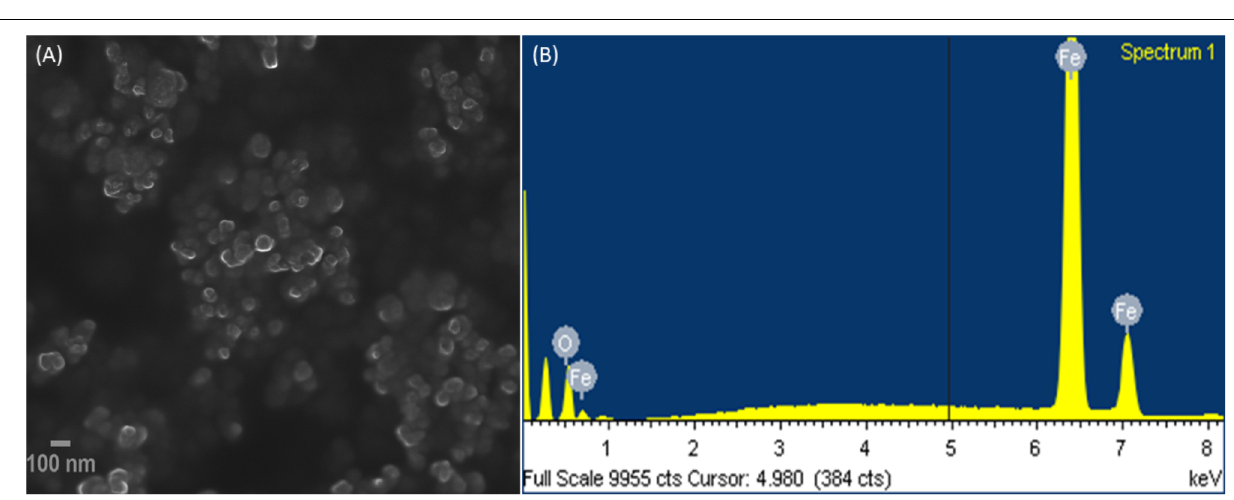
Frontiers in Microbiology |